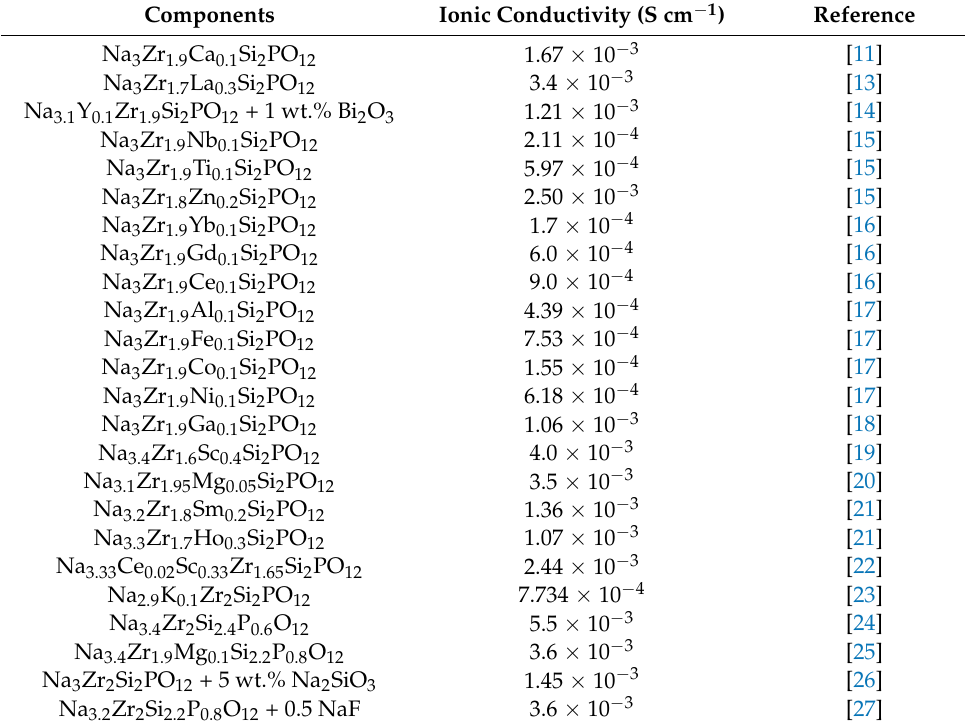
Table 1. The ionic conductivities of previously reported NASICON electrolytes with different dopants at room